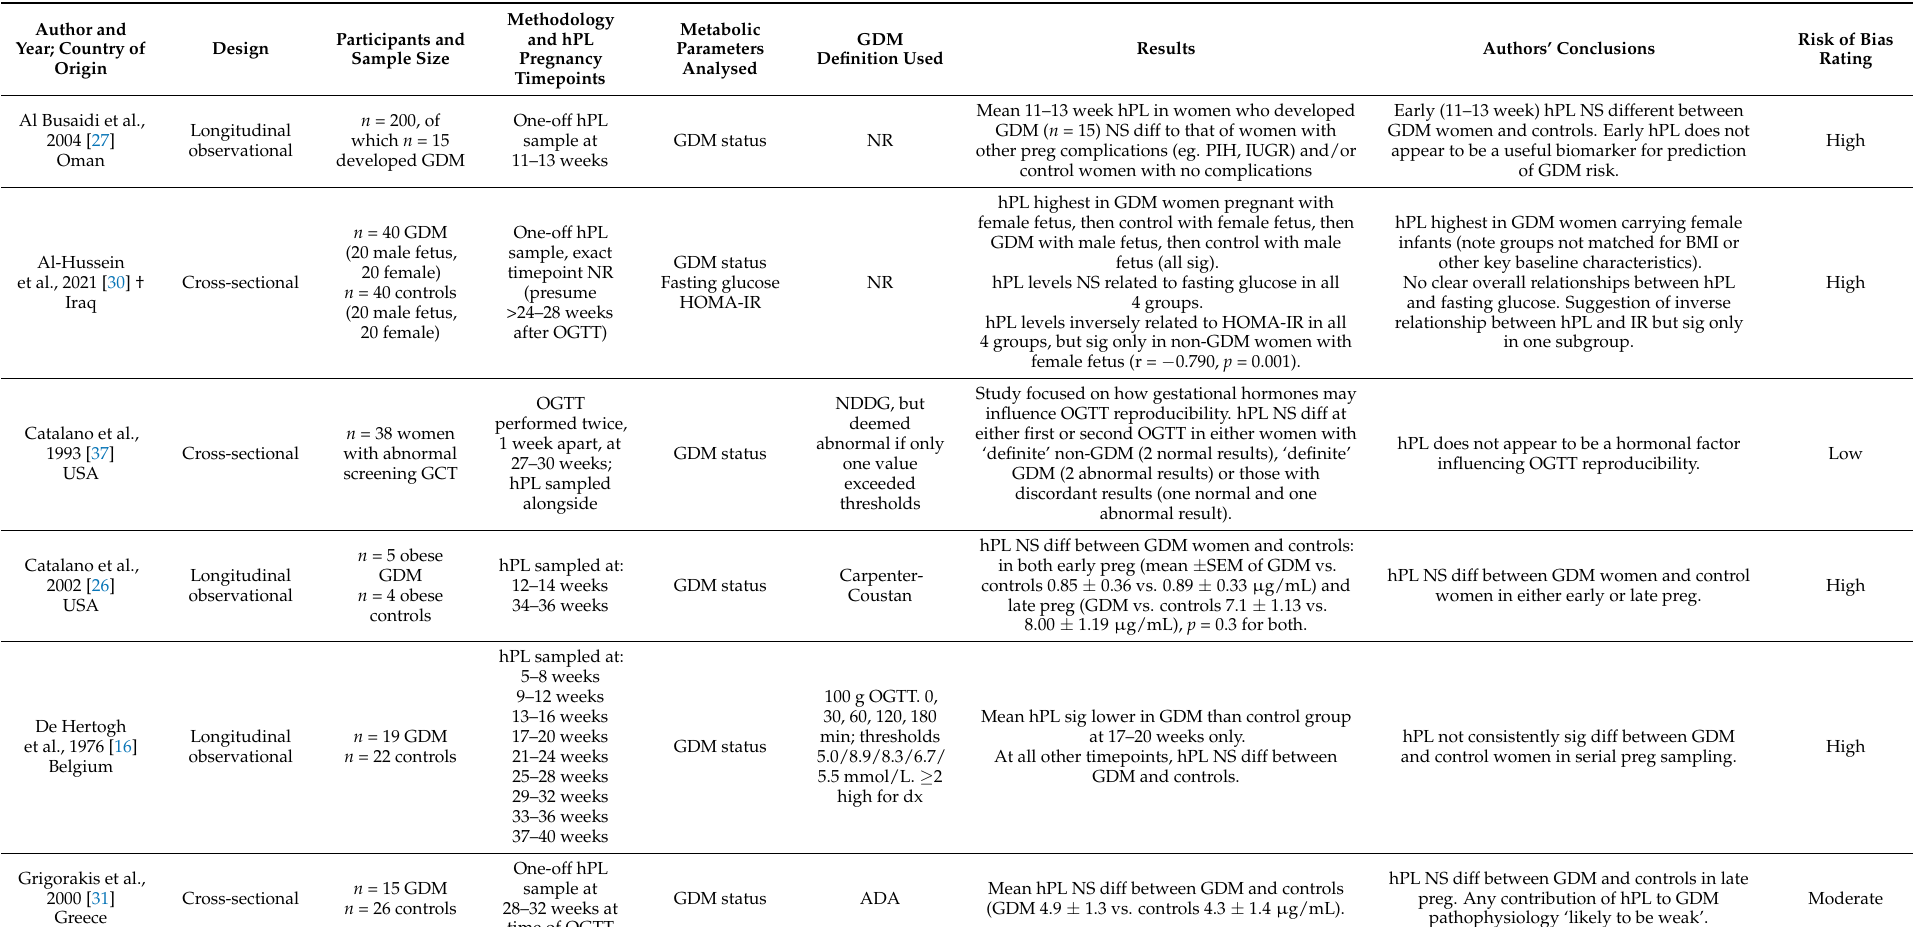
Table A2. Studies examining hPL in pregnancies affected by gestational diabetes mellitus—17